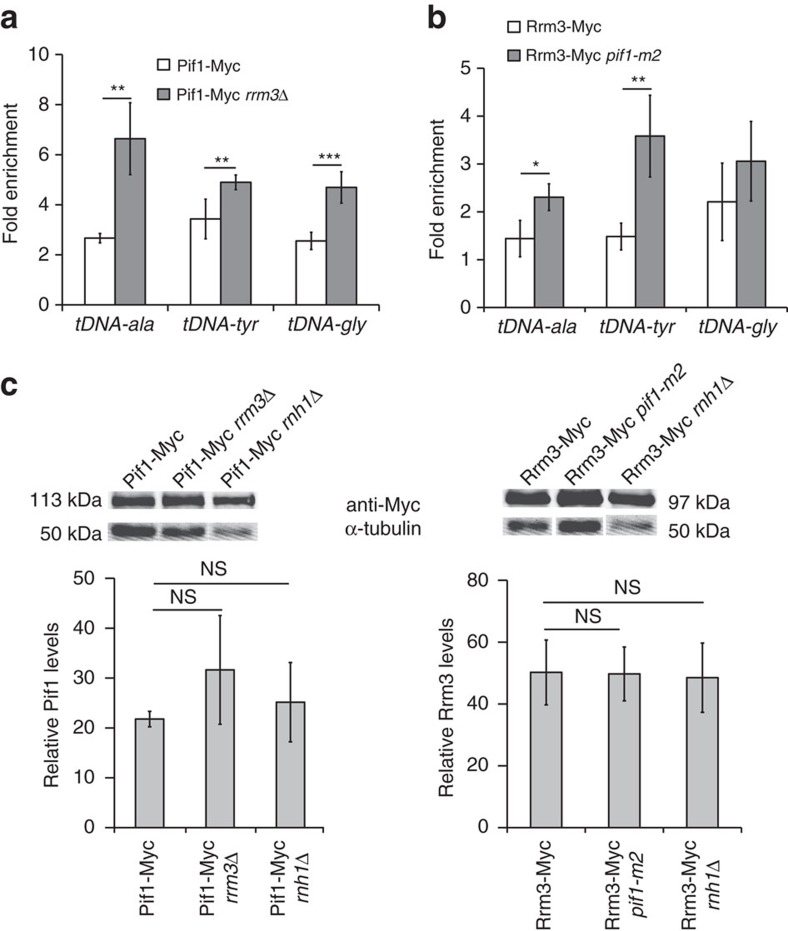
Pif1 and Rrm3 bind tDNAs.Enrichment of Pif1 (ChIP/input) or Rrm3 (ChIP/input) at tDNAs was normalized to helicase enrichment at YBL028C, a site that has low binding to both helicases. (a) Fold enrichment ([ChIP/input] tDNA/[ChIP/input] YBL028C) of Pif1-Myc in asynchronous wild-type (WT) and in rrm3Δ cells at tDNAalaHO, tDNAtyrHO and tDNAglyHO. (b) Fold enrichment of Rrm3-Myc in asynchronous WT and pif1-m2 cells at tDNAalaHO, tDNAtyrHO and tDNAglyHO. Full blots are shown in Supplementary Fig. 7. (c) Western blot (top) and its quantification (bottom) showing Pif1 or Rrm3 expression levels in WT, rrm3Δ, pif1-m2 and rnh1Δ cells. All quantification was normalized to the loading control, α-tubulin. The difference in Pif1 abundance between WT and rrm3Δ or rnh1Δ cells was not significant (NS) (P>0.05). Similarly, Rrm3 abundance was the same between WT and pif1-m2 or rnh1Δ cells. Error bars are±s.d. for at least three independent experiments per strain. P-values here and elsewhere were obtained using unpaired two-tailed Student's t-test. Here and in subsequent figures, * indicates P<0.05, ** indicates P⩽0.009, and *** indicates P⩽0.0009.